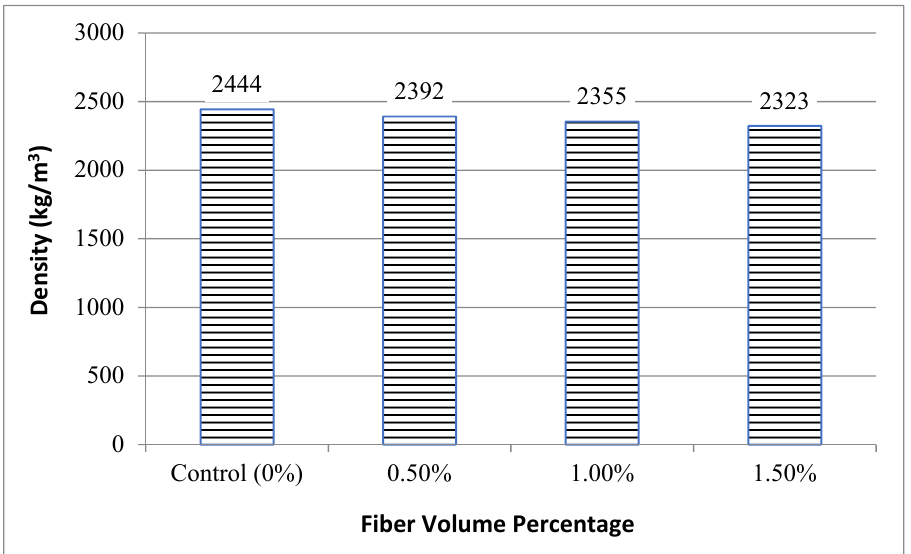
Figure 3. The effect of PA fibers at 0.5%, 1.0%, and 1.5% additions on densities of concrete mixes as compared to the control mix (0.0% PA).